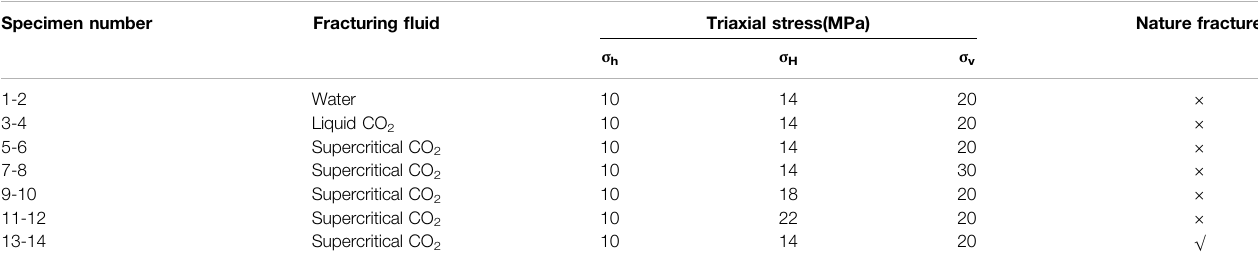
TABLE 3 | The experimental schemes of fracturing